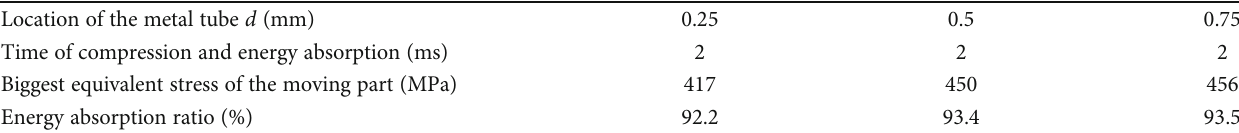
Table 4: Simulation results of compression and energy absorption parameters of metal tubes located in di ff erent positions.